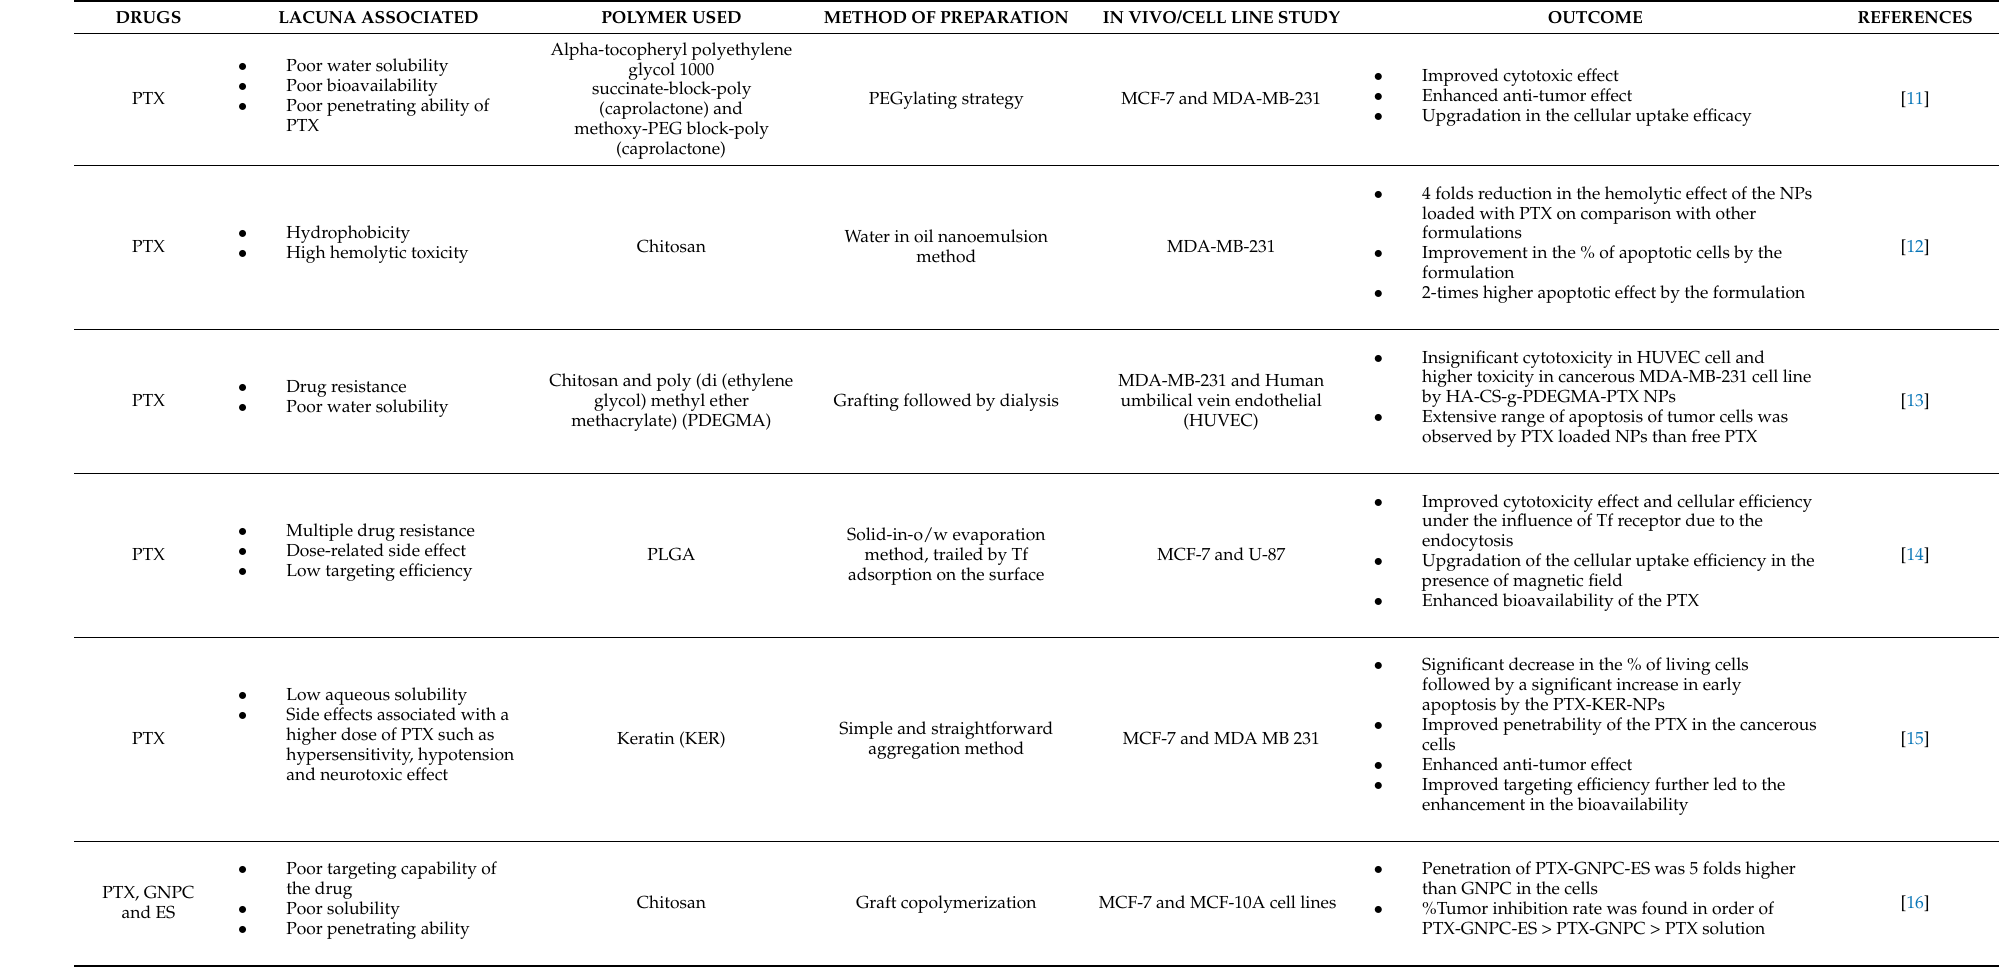
Table 1. Paclitaxel and their combination polymeric nanoparticles for breast cancer